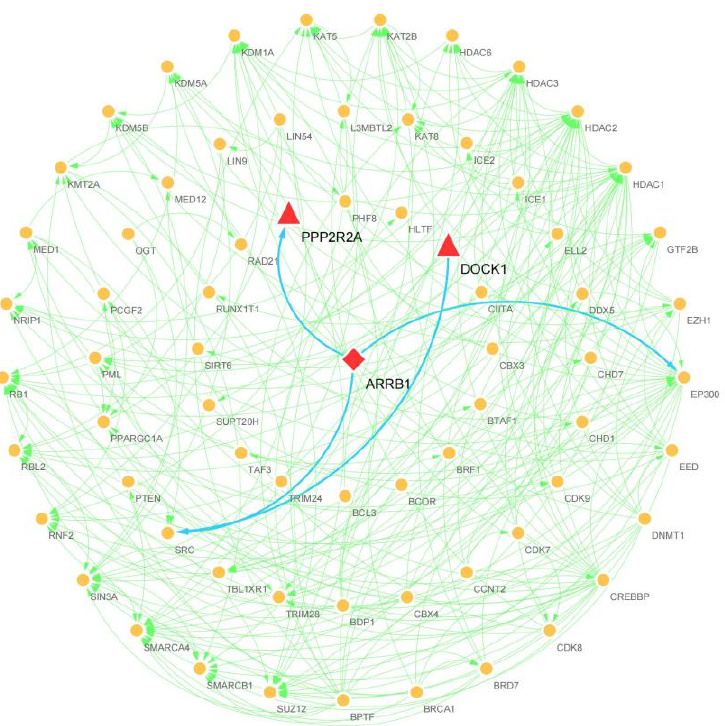
Figure 5. Regulatory network of central host genes and TFs of DEcircRNAs constructed based on Cytoscape software. Transcription factors are indicated by circles; predicted key transcription factors are indicated by diamonds; triangles represent central host genes.